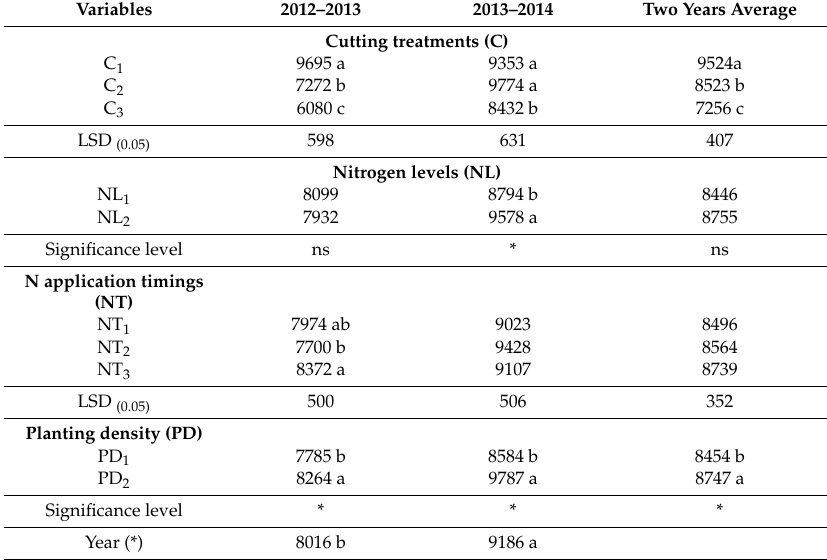
Table 3. Biomass yield (kg ha − 1 ) of canola under cutting treatments, nitrogen levels and application timings under di ff erent planting